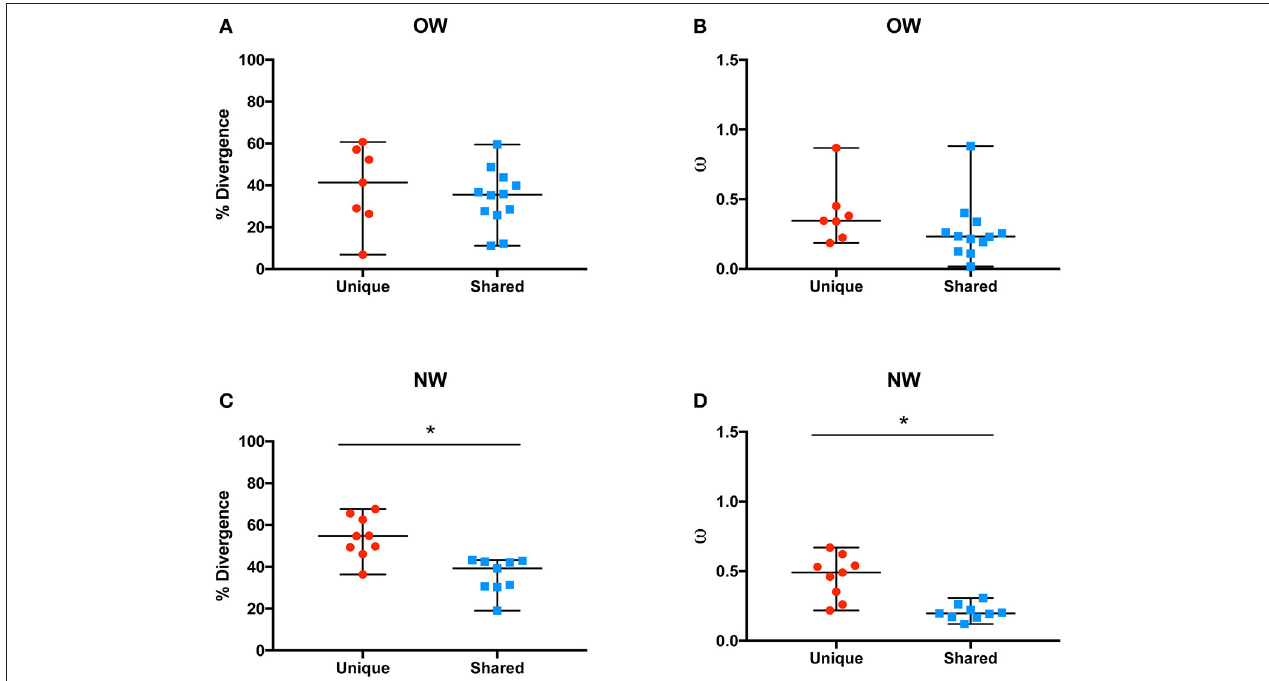
FIGURE 2 | Average molecular divergence of unique and shared Old World (A) and New World (C) salivary proteins (top), and rate of non-synonymous over synonymous replacements (omega— ω ) of unique and shared Old World (B) and New World (D) salivary proteins. * p < 0.05.